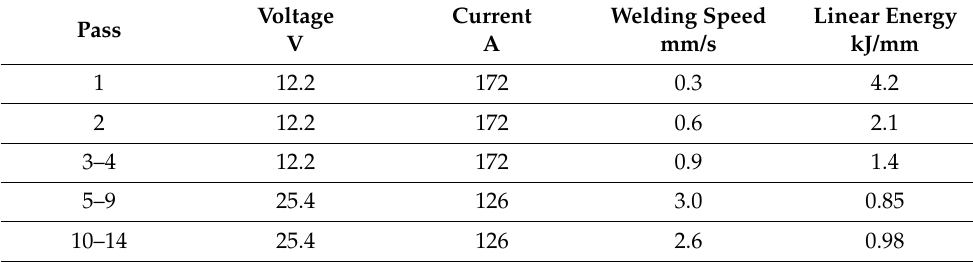
Table 3. Welding parameters and linear